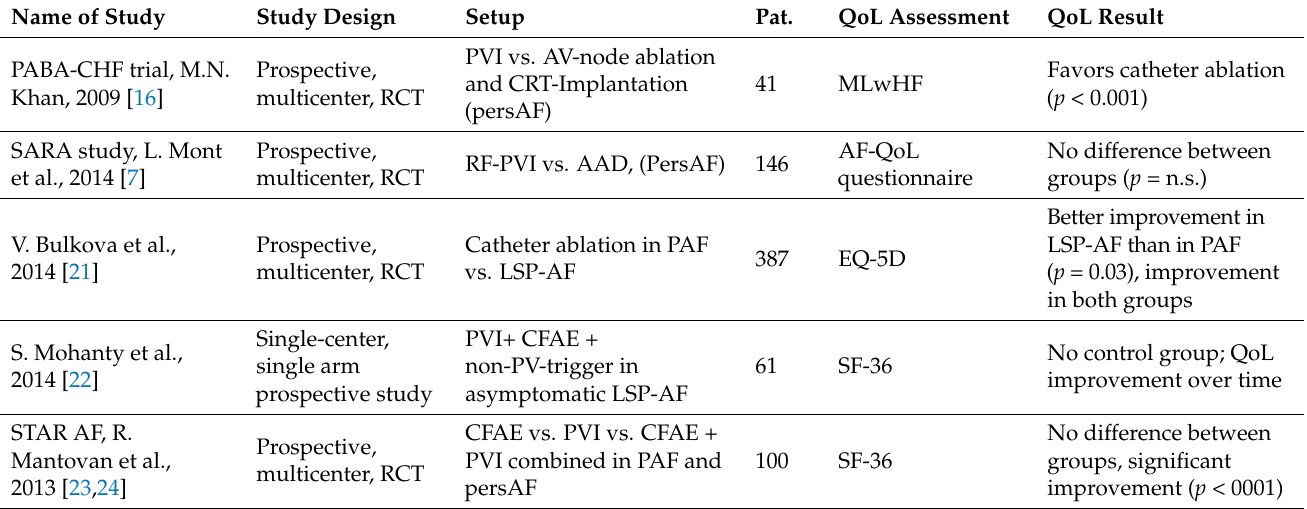
Table 3. Studies concerning the impact of catheter ablation on QoL in persistent AF (CFAE: com- plex fractionated atrial electrograms, CRT: cardiac resynchronization therapy, LSP: long-standing persistent atrial